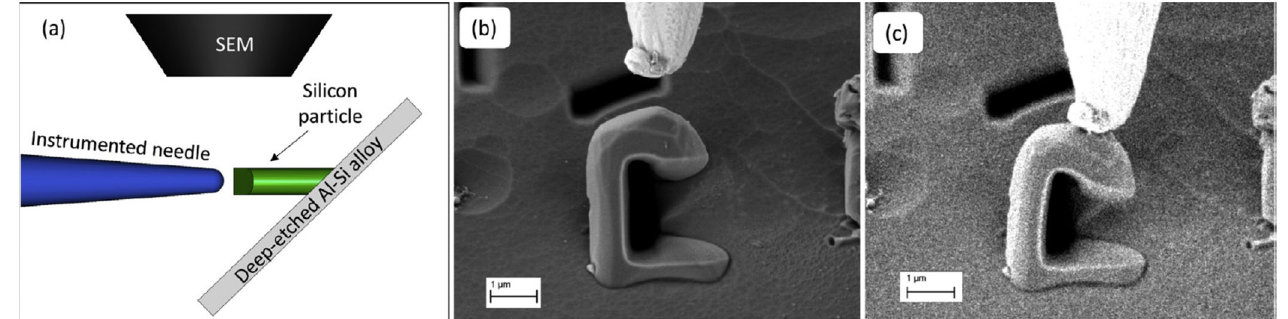
Figure 5. Strength test of silicon microparticles in A356 aluminium alloy: ( a ) Scheme of the micro ‐ mechanical test; ( b ) C ‐ shaped particle and the tungsten tip before test; ( c ) Last frame before particle fracture, from [36].